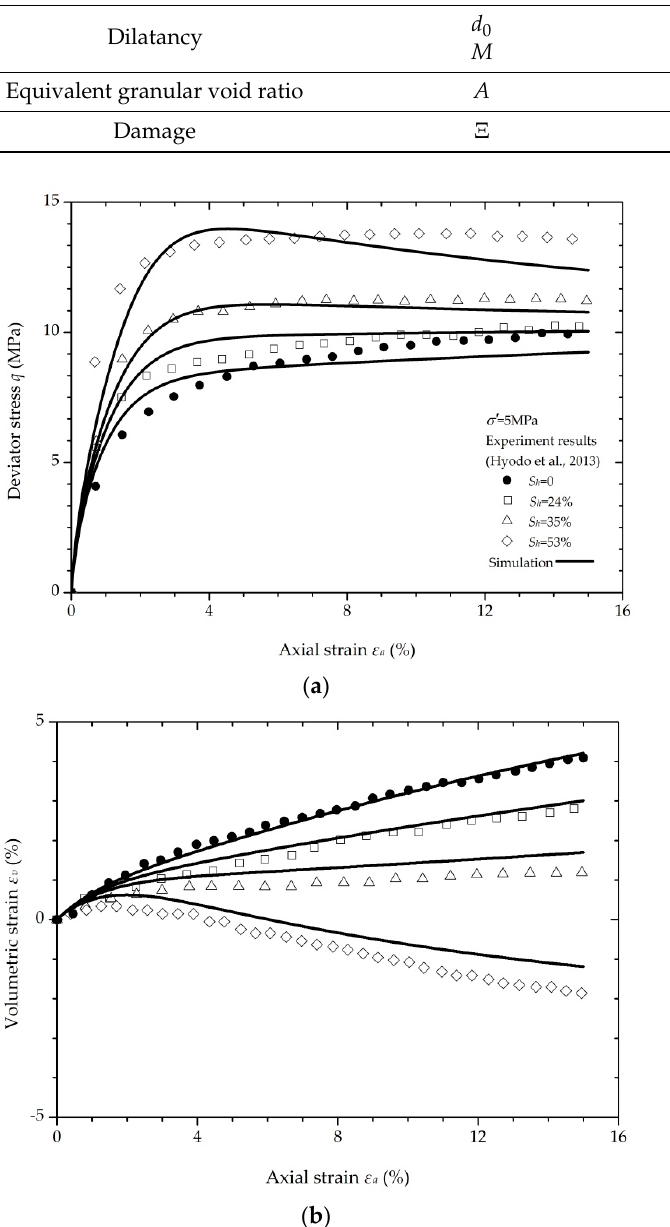
Figure 5. Comparison between the drained triaxial test results and the model predictions for MHBS with different hydrate saturations: ( a ) relationship between deviator stress q and axial strain ε a ; ( b ) relationship between volumetric strain ε v and axial strain ε a .